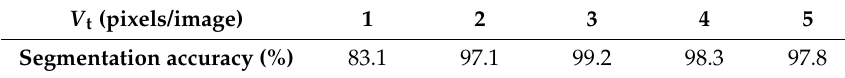
Table 1. Segmentation accuracy of continuous gestures with different values of V t